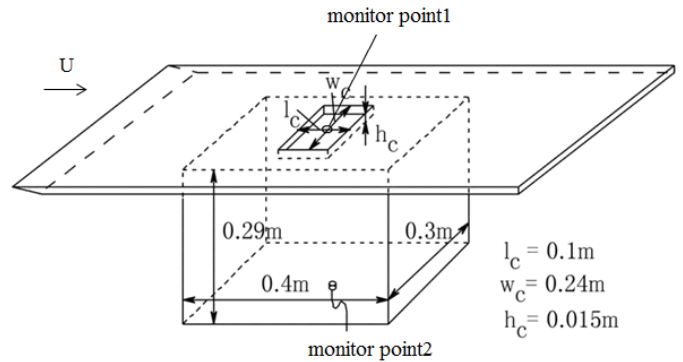
Figure 1. Cavity model and receiver location.